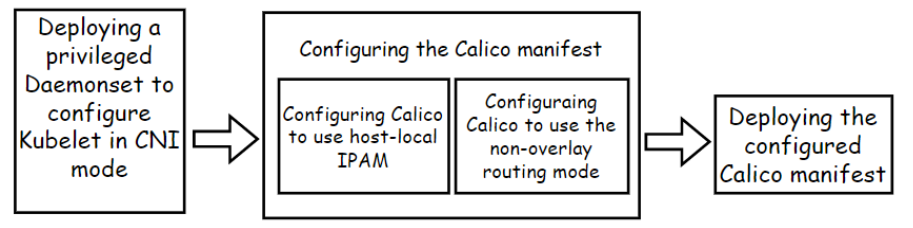
Figure 4. Steps for reconfiguring the Calico CNI plugin in